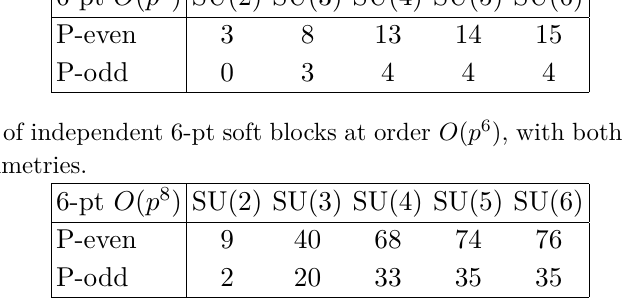
Table 12 . Number of independent 6-pt soft blocks at order O ( p 8 ) , with both parities and different finite N flavor f